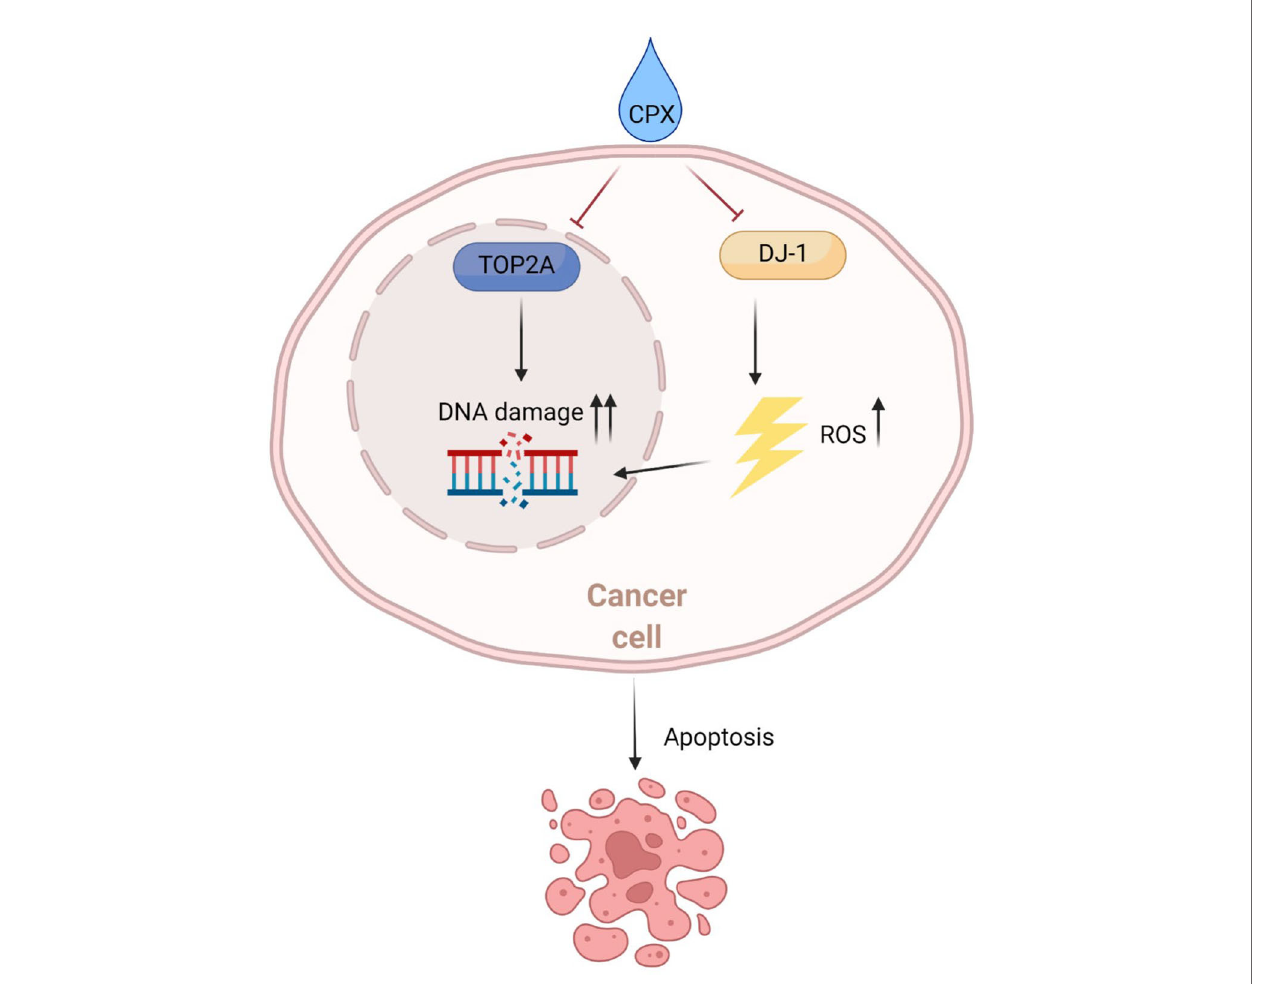
FIGURE 8 | Schematic showing the potential therapeutic effects of CPX toward LUAD. Mechanistically, CPX causes DNA damage by inducing ROS and suppressing TOP2A expression, thereby blocking DNA repair, aggravating DNA damage, and causing